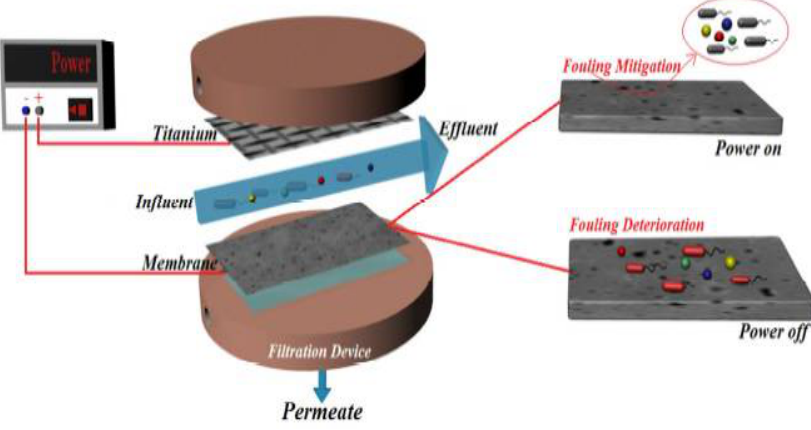
Figure 37. Illustration of electro-assisted membrane coupling technology [166].